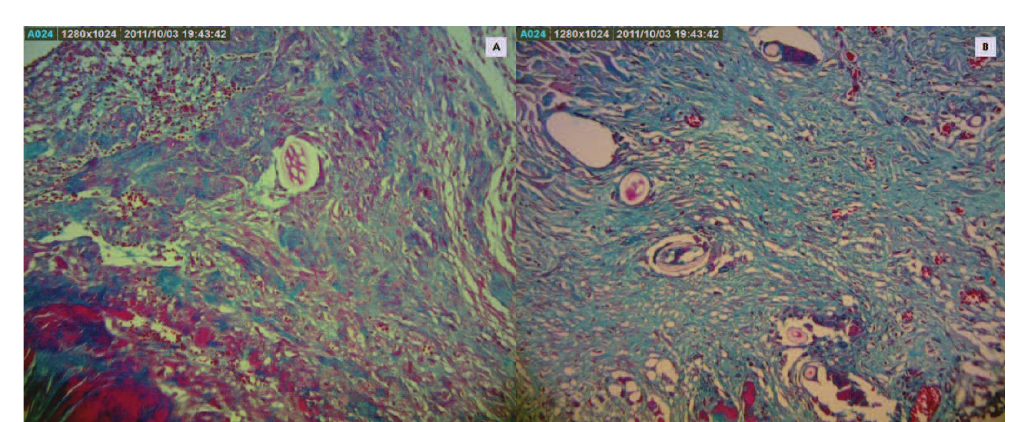
Fig. 6 – Lâminas do grupo D de Ti (A) e do Pm (B) na coloração de tricrômico de Masson, indicando fibrose moderada em